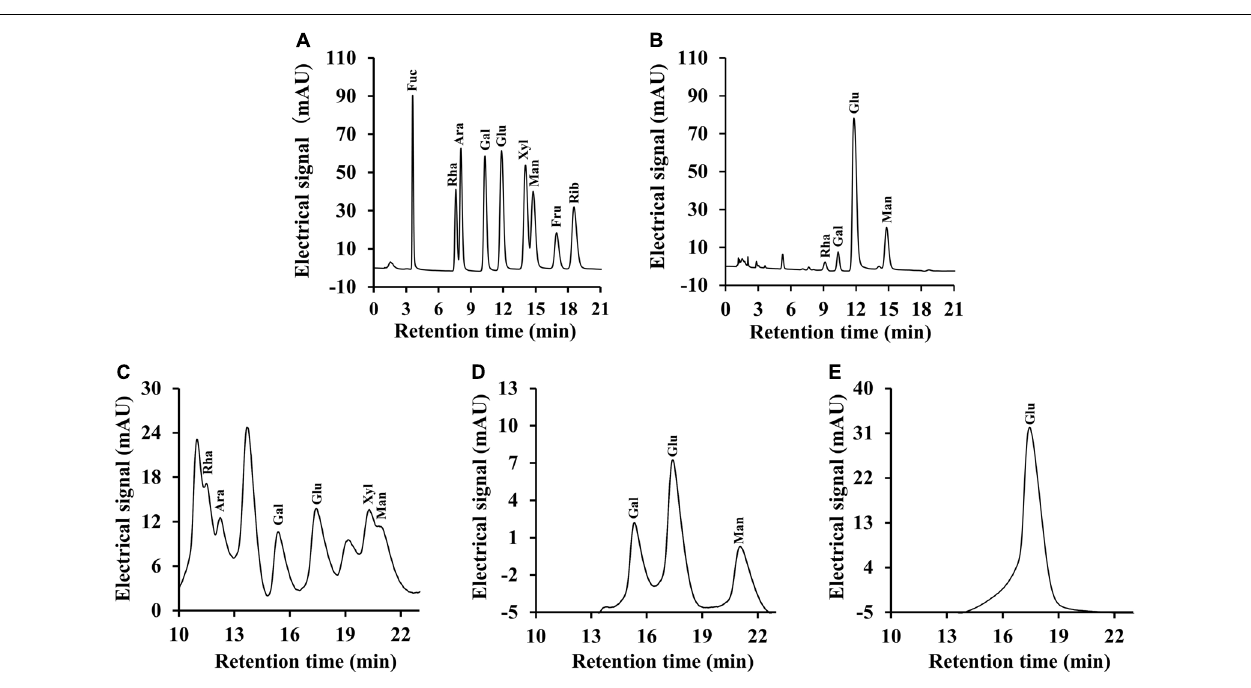
FIGURE 4 | Ion chromatography profiles of the monosaccharide standards, CSFP, CSFP1- β , and CSFP2- α . (A,C) The monosaccharide standards, (B) CSFP, (D) CSFP1- β , and (E) CSFP2- α . Fuc, Ara, Rha, Gal, Glc, Xyl, Man, Fru, and Rib represent fucose, arabinose, rhamnose, galactose, glucose, xylose, mannose, fructose, and ribose,